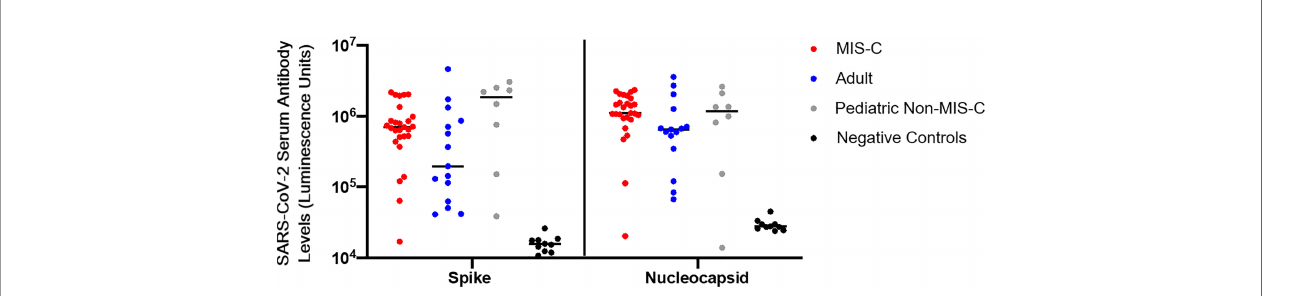
FIGURE 2 | SARS-CoV-2 serology. Serologies in luminescence units for antibodies to SARS-CoV-2 spike and nucleocapsid proteins from adult convalescent (blue), pediatric convalescent (gray), and MIS-C (red) subjects, and negative controls (black). Negative controls are pre-pandemic adult samples. Assays were conducted in duplicate on 10uL of 1:10 diluted plasma. Black line represents the median value for